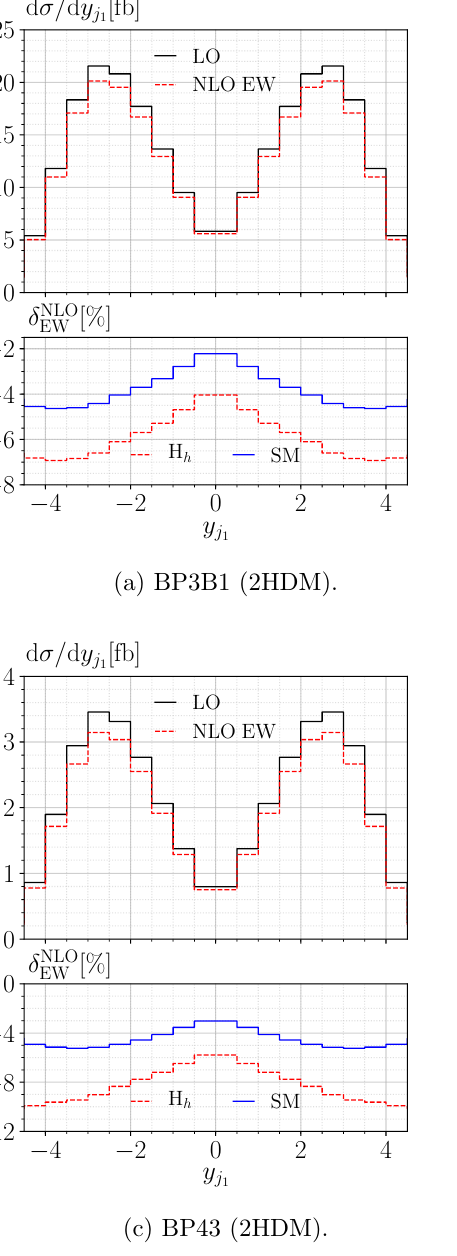
j 1 for heavy Higgs production in VBF for